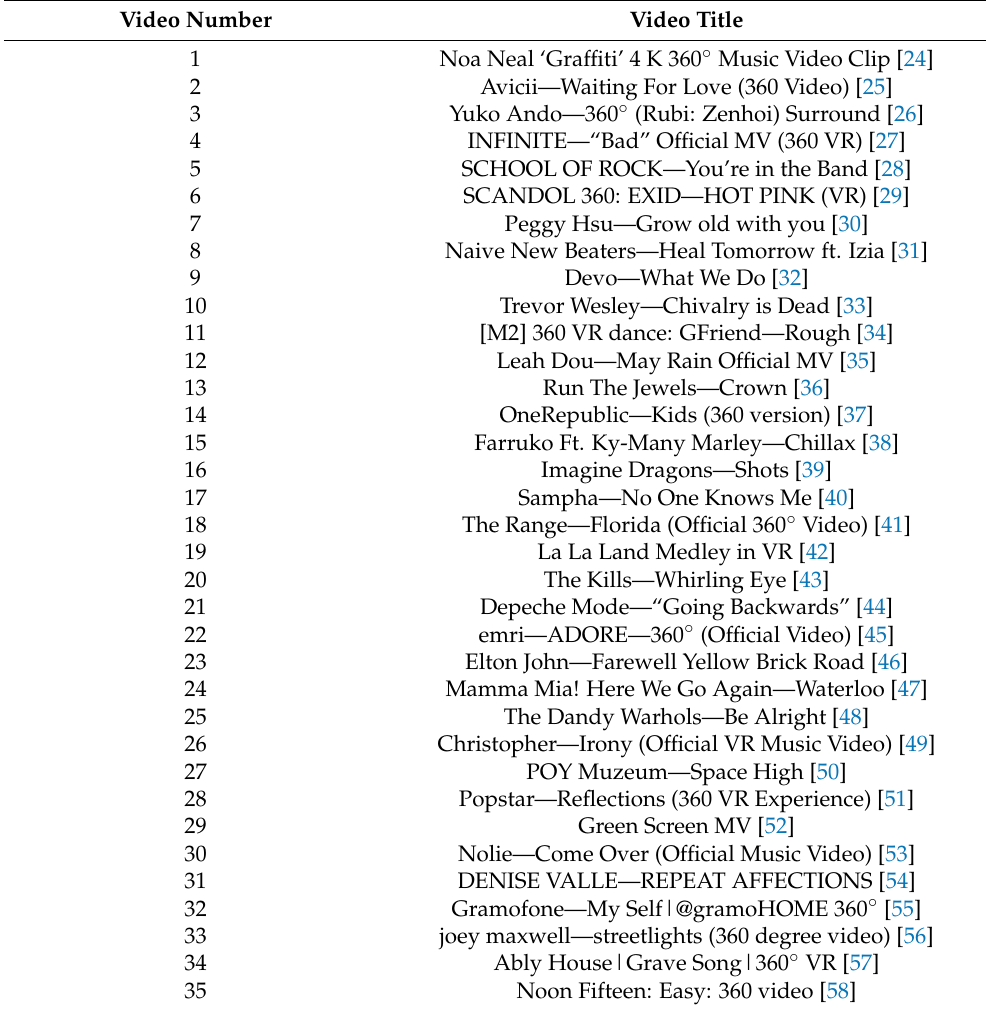
Table 1. The 360-degree VR music